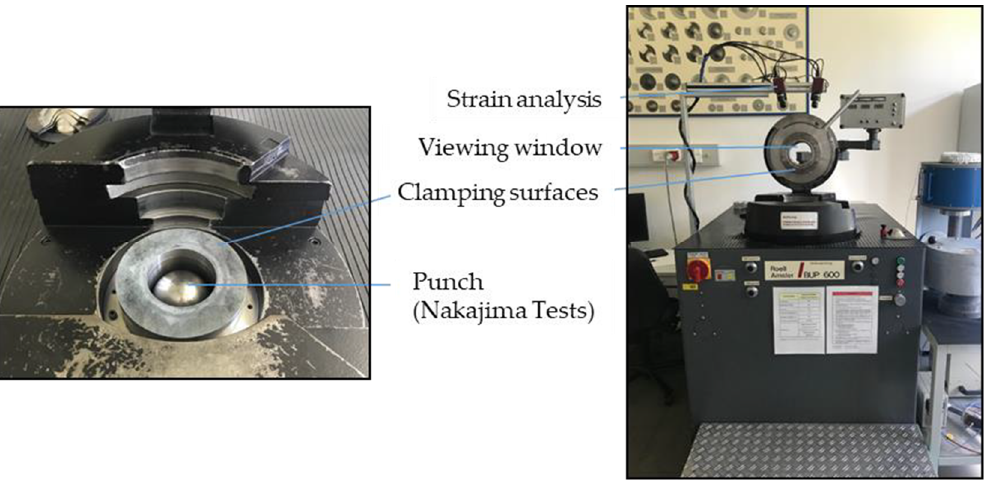
Figure 1. Material testing machine ZwickRoell GmbH & Co. KG BUP 600, Ulm, Germany (in use at the Technical University Freiberg) [Vitesco Technologies Group AG].